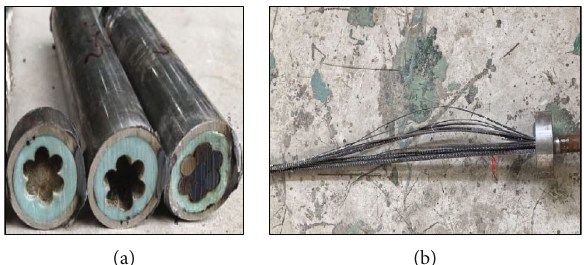
Figure 3: The failure mode of the “ BFRP-connector-strand. ” (a) Steel strand pulled out from the steel connector; (b) BFRP tendon rupture.